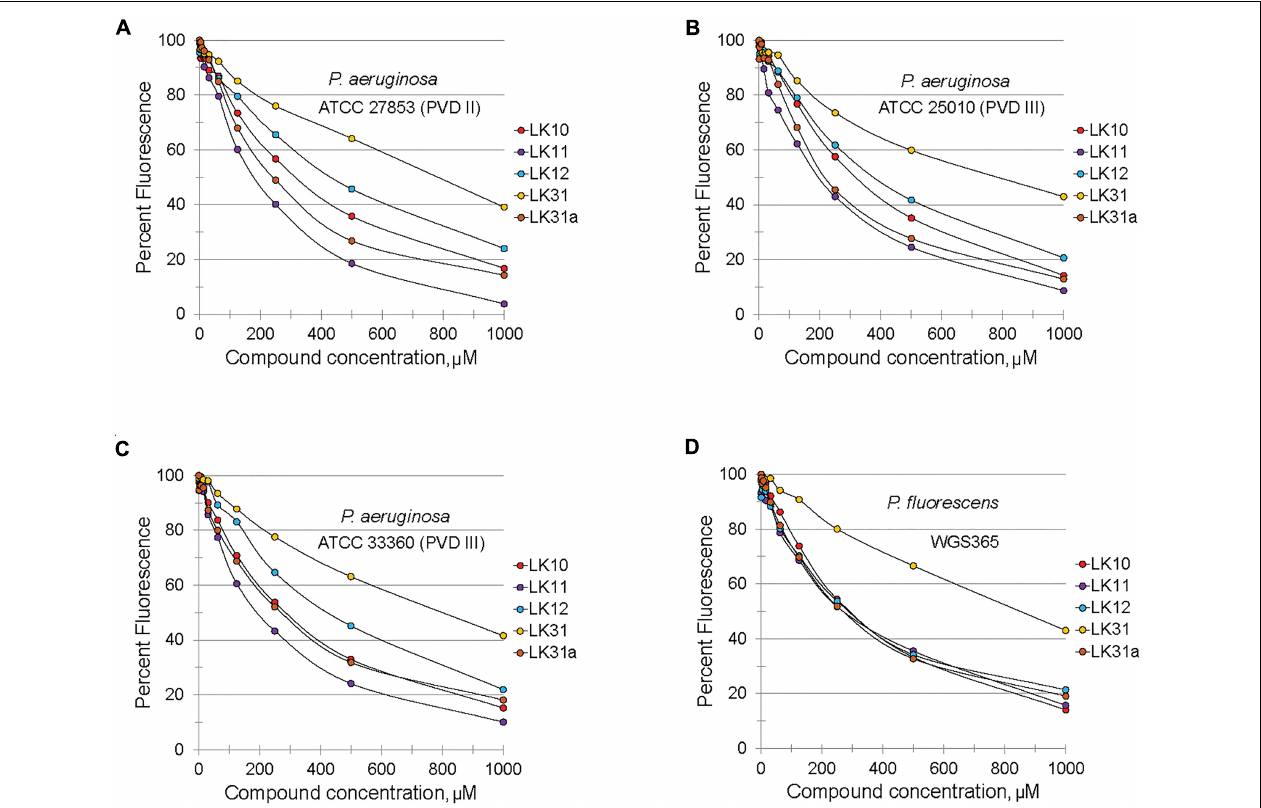
FIGURE 4 | Selected hits inhibit fluorescence of structurally diverse pyoverdines. (A–D) Fluorescence of bacteria-free, pyoverdine-rich filtrate after 5 min incubation with compounds at varying concentrations or DMSO. Filtrates were produced from the indicated strains. At least two biological replicates were